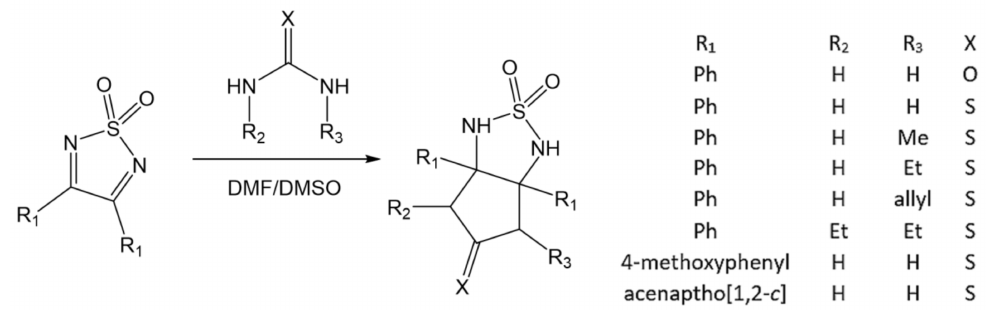
Figure 7. Double addition of substituted ureas/tioureas to C=N bonds of 3,4-diphenyl 1,2,5- thiadiazole 1,1-dioxide [73,86].